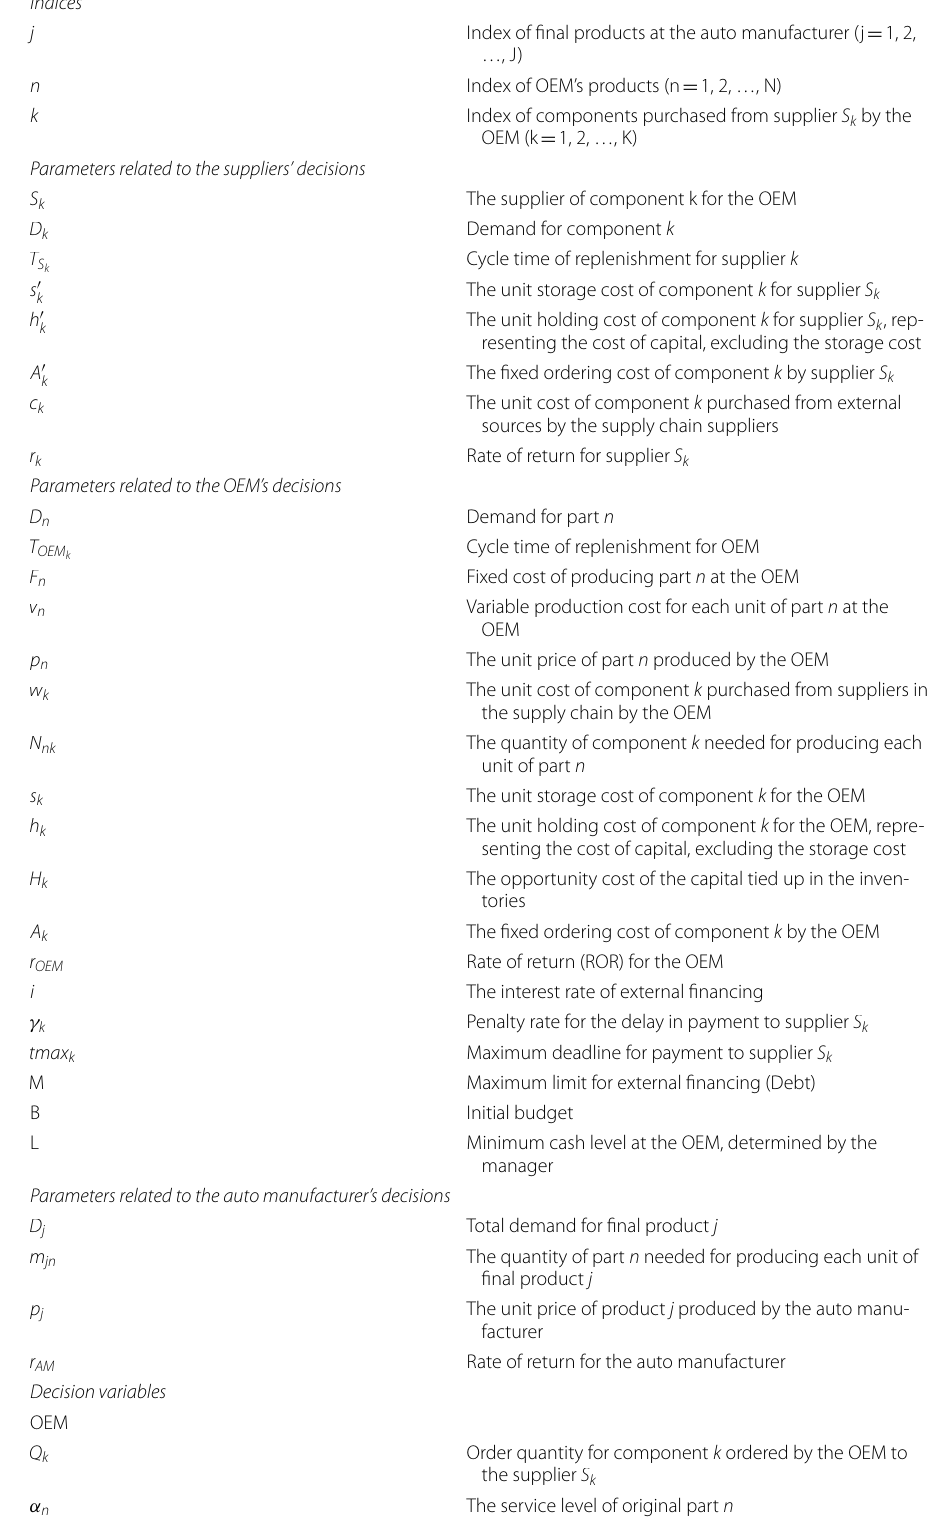
Table 3 Summary of